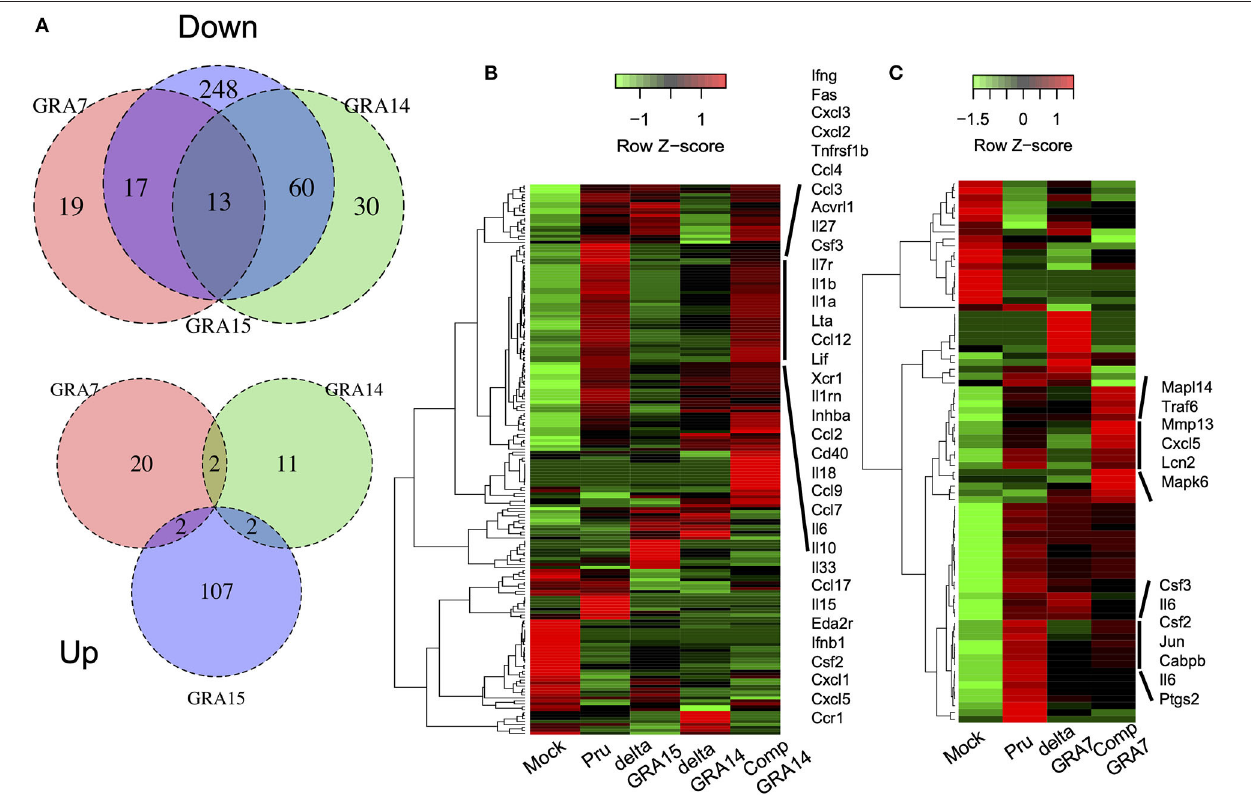
FIGURE 6 | GRA deficiency resulted in downregulation of gene expression mediated by NF κ B. RNA-seq analysis of Raw246.7 macrophage cells infected for 24h with parasite strains and the uninfected cells (Mock) ( n = 1 per group). DESeq analysis identified genes with a more than 2-fold change in expression between the GRA deficient strain and the parental Pru and complemented strains following infection. (A) Venn diagrams comparing GRA7, GRA14, and GRA15-dependent DEGs during T. gondii infection: down, downregulated; up, upregulated. (B) Heatmap showing that the most significantly enriched pathway associated with the GRA14 expression status was the cytokine-cytokine receptor interaction, which contained a subset of 41 genes. Rows represent samples from different processes, and columns represent genes. (C) Heatmap showing that the most significantly enriched pathway associated with the GRA7 expression status was the IL17 signaling pathway, which contained a subset of 91 genes. Rows represent samples from different processes, and columns represent genes. The cluster shown in (B,C) , which was upregulated when GRA14 or GRA7 expression was restored, is enlarged on the right. The experiment for GRA14 was performed in tandem with GRA15, and the experiment for GRA7 was performed